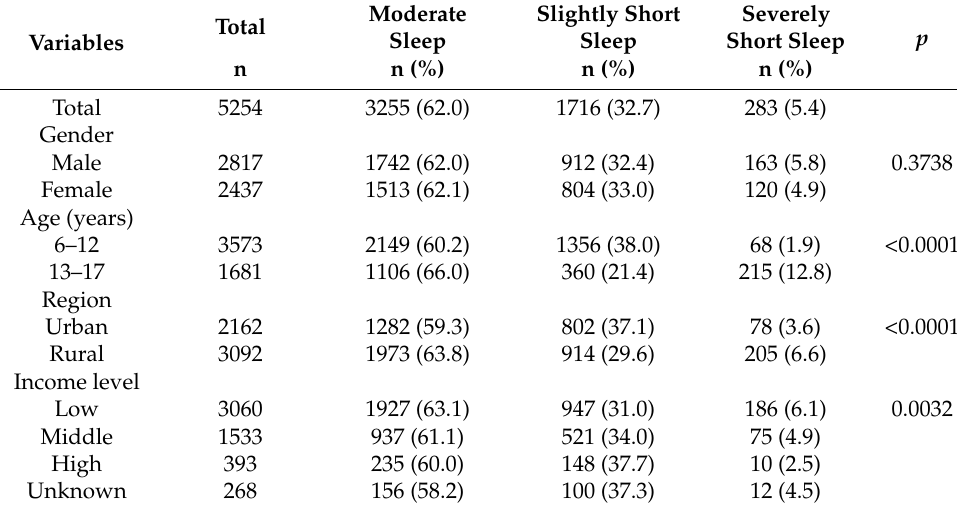
Table 1. Sleep duration of children with different